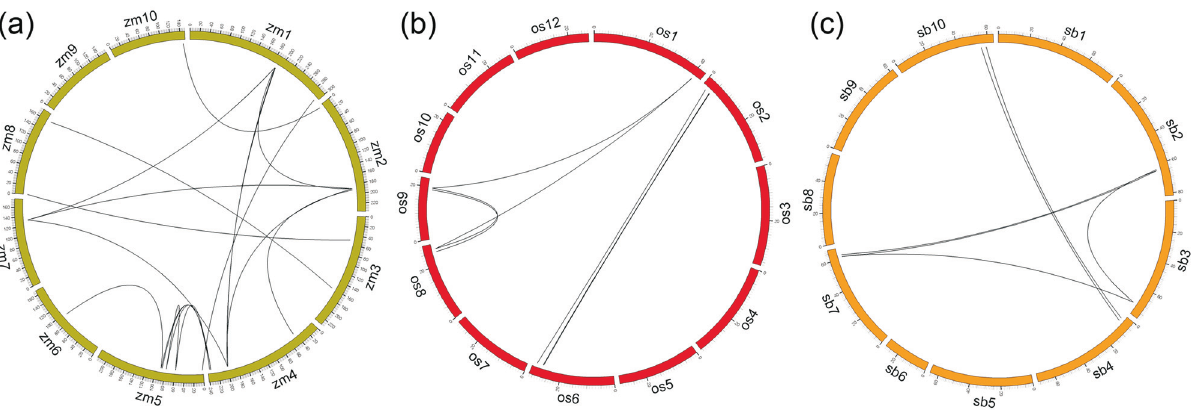
Figure 3 - Synteny analysis of maize (a), rice 9 (b), and sorghum (c) SPLs. Maize, sorghum, and rice chromosomes were labeled zm, sb and os by differ- entcolorboxes,respectively.Thenumberalongeachchromosomeboxindicatesequencelengthofeachchromosomeinmegabases.Blacklinesrepresent the syntenic relationships between